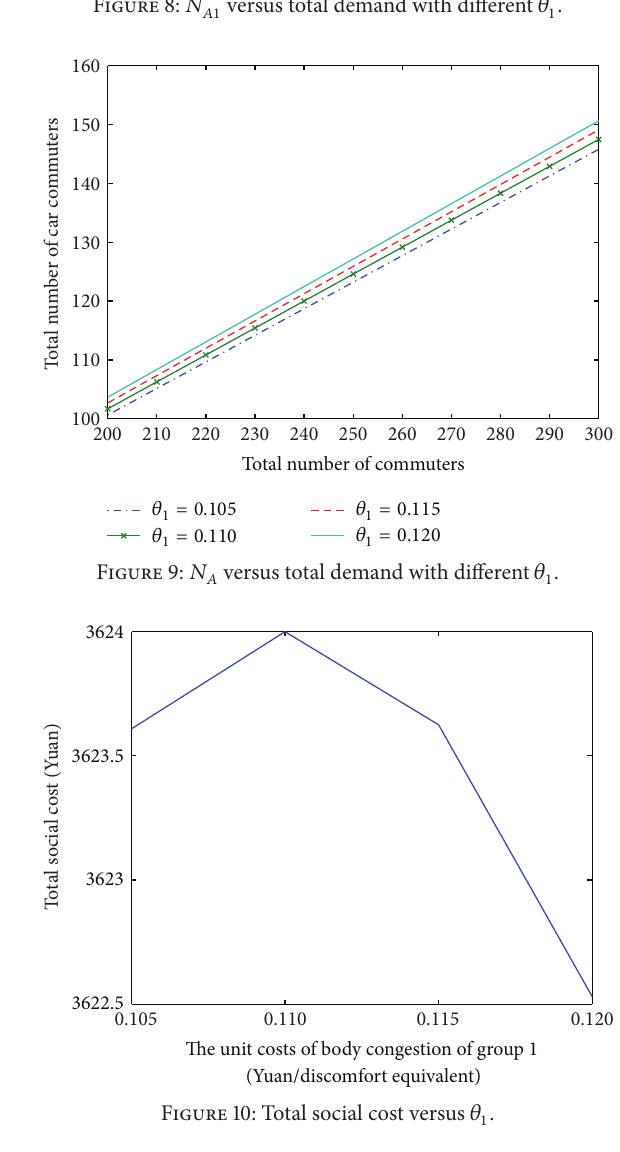
Figure 8: 𝑁 𝐴1 versus total demand with different 𝜃 1 .